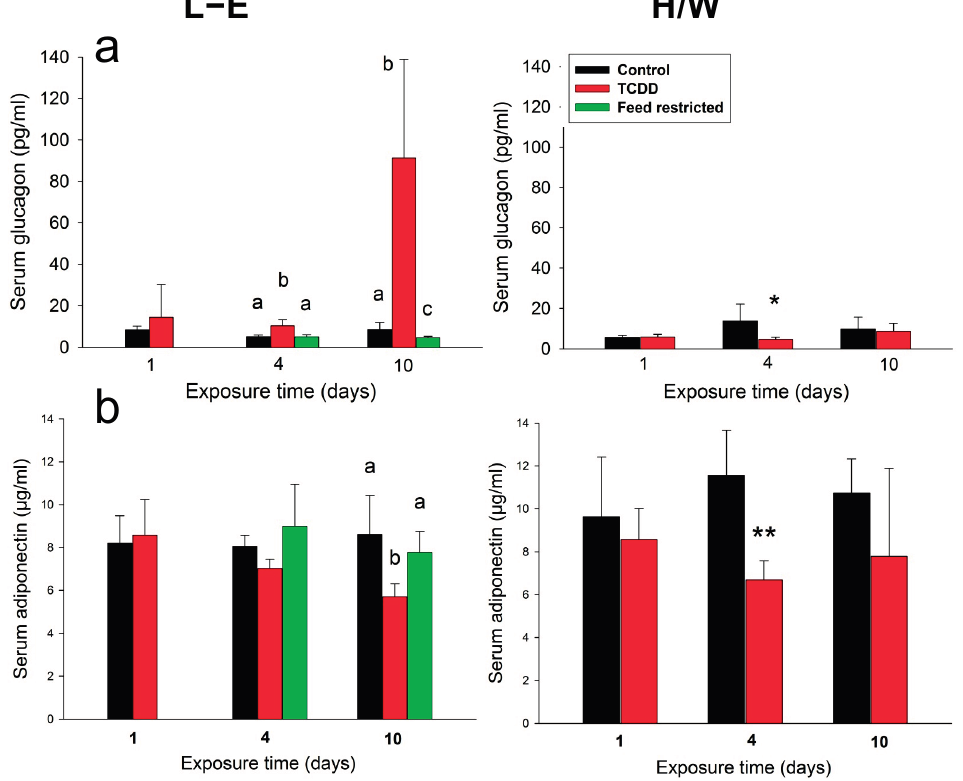
Figure 3. The effect of TCDD or feed restriction on ( a ) serum glucagon and ( b ) adiponectin concentrations in L-E ( left panel) and H/W rats ( right panel) as a function of time (mean ± SD). The conditions are as in Figure